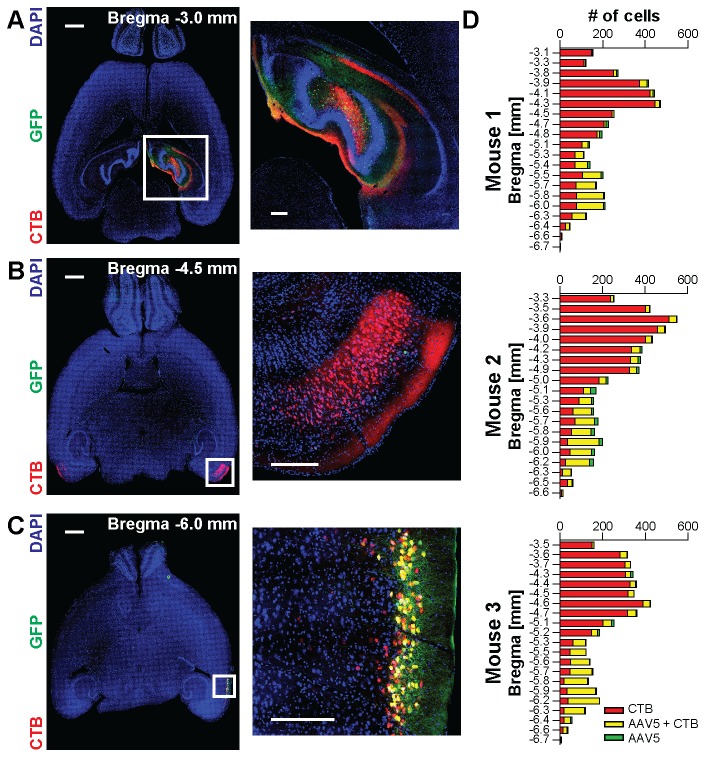
rAAV5 injections in the dentate gyrus lead to retrograde labeling of cells in the ventral entorhinal cortex.A) Confocal images from horizontal brain sections at -3 mm along the dorso-ventral axis in reference to Bregma taken from a mouse that received a co-injection of rAAV5 driving expression of GFP (green) and fluorescently labeled retrograde tracer CTB (red) in the dentate gyrus. B) same as A), for Bregma -4.5 mm. C) same as A), for Bregma -6.0 mm. Double labeled cells in the ventral entorhinal cortex appear yellow. White squares on the left indicate parts of images shown in higher magnification on the right. Scale bars: for whole sections: 1 mm; for insets: 250 µm. D) Cell counts of CTB-only labeled cells (red), GFP-only labeled cells (green) and double positive cells (yellow) in horizontal sections of the ipsilateral entorhinal cortex along the dorso-ventral axis of three individual mice.